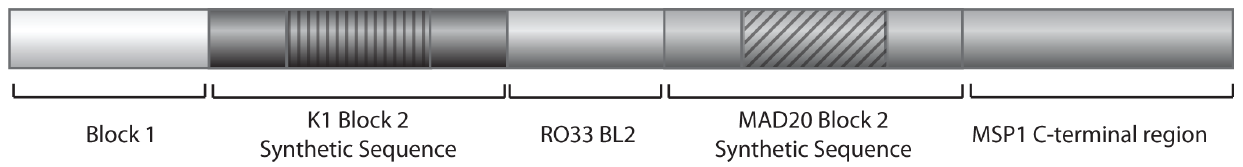
Figure 1. Schematic diagram of the MSP-1-BBM construct which encodes the N-terminal MSP-1 Block 1 region, the K1 Block 2 synthetic sequence, the RO33 Block 2 sequence, the MAD20 Block 2 synthetic sequence [ 31 ] and a C-terminal fragment encoding residues 1571 to 1702 of MSP-1 precursor protein of P.falciparum . The Block 2 region is arranged similar to natural alleles. Synthetic Block 2 repeat sequences of the K1 and MAD20 serotypes are indicated by vertical and diagonal hatched markings, respectively.